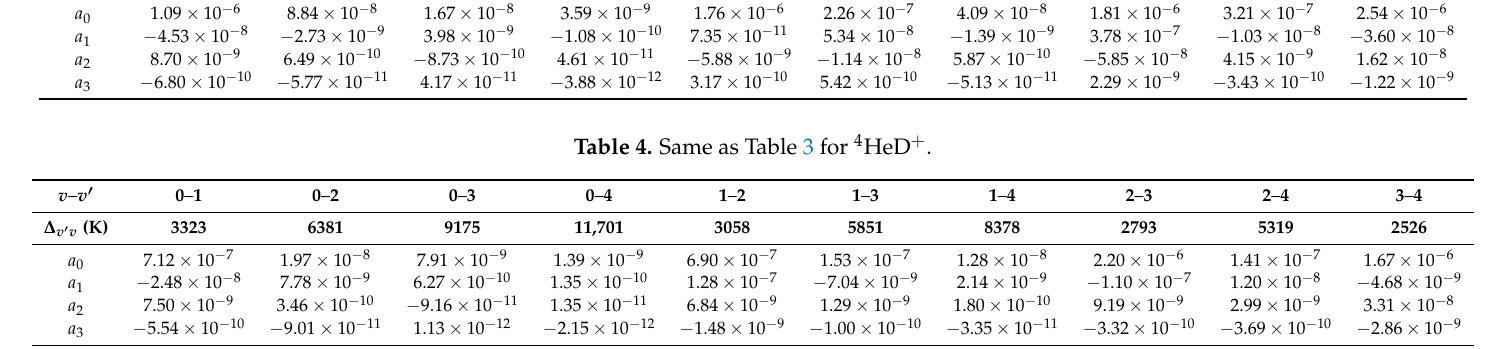
( x ) = P fit ( x ) of Equation (4) for 4 HeH + . The upper line in the header of the table specifies the vv (cid:48) v (cid:48) v